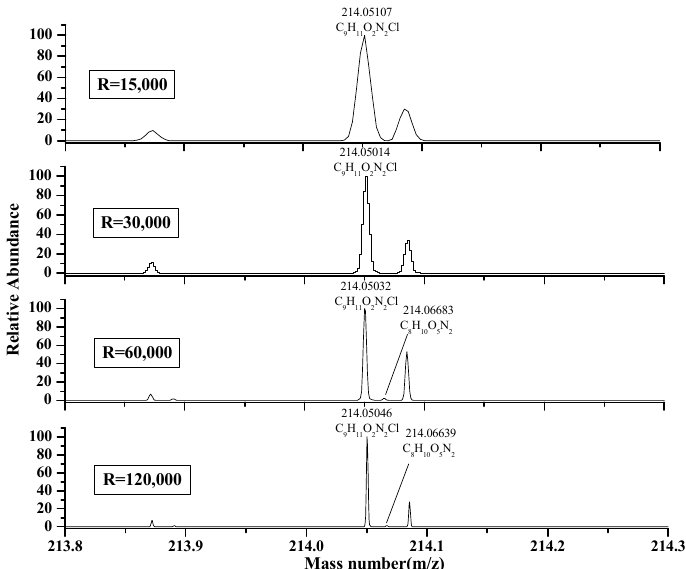
Figure 3. Extracted ion chromatograms andquality accuracy of the spiked (10 μ g/kg) monolinuron qualitative ion (214.0504) in the orange juice sample at different resolutions.